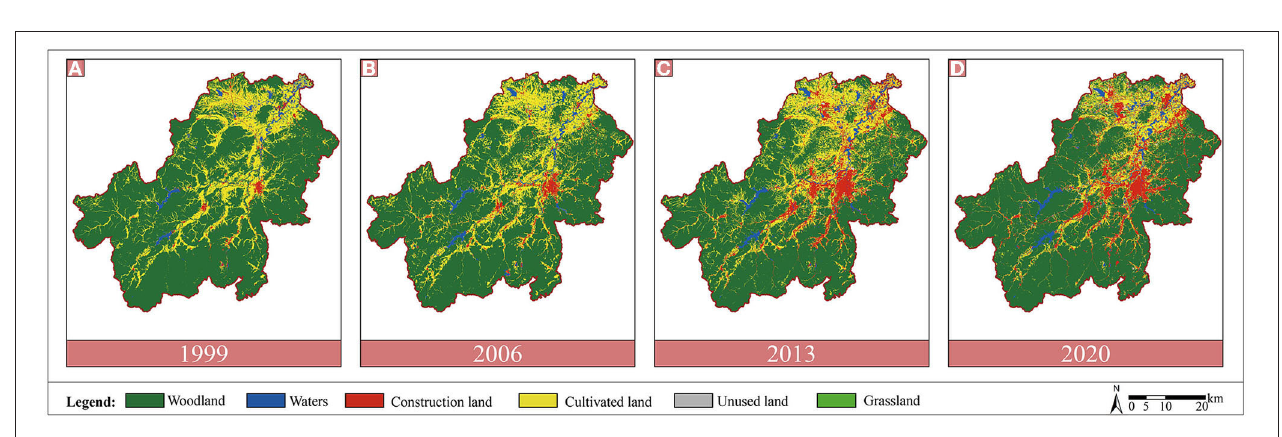
FIGURE 2 | Land use maps for (A) 1999, (B) 2006, (C) 2013, and (D) 2020.